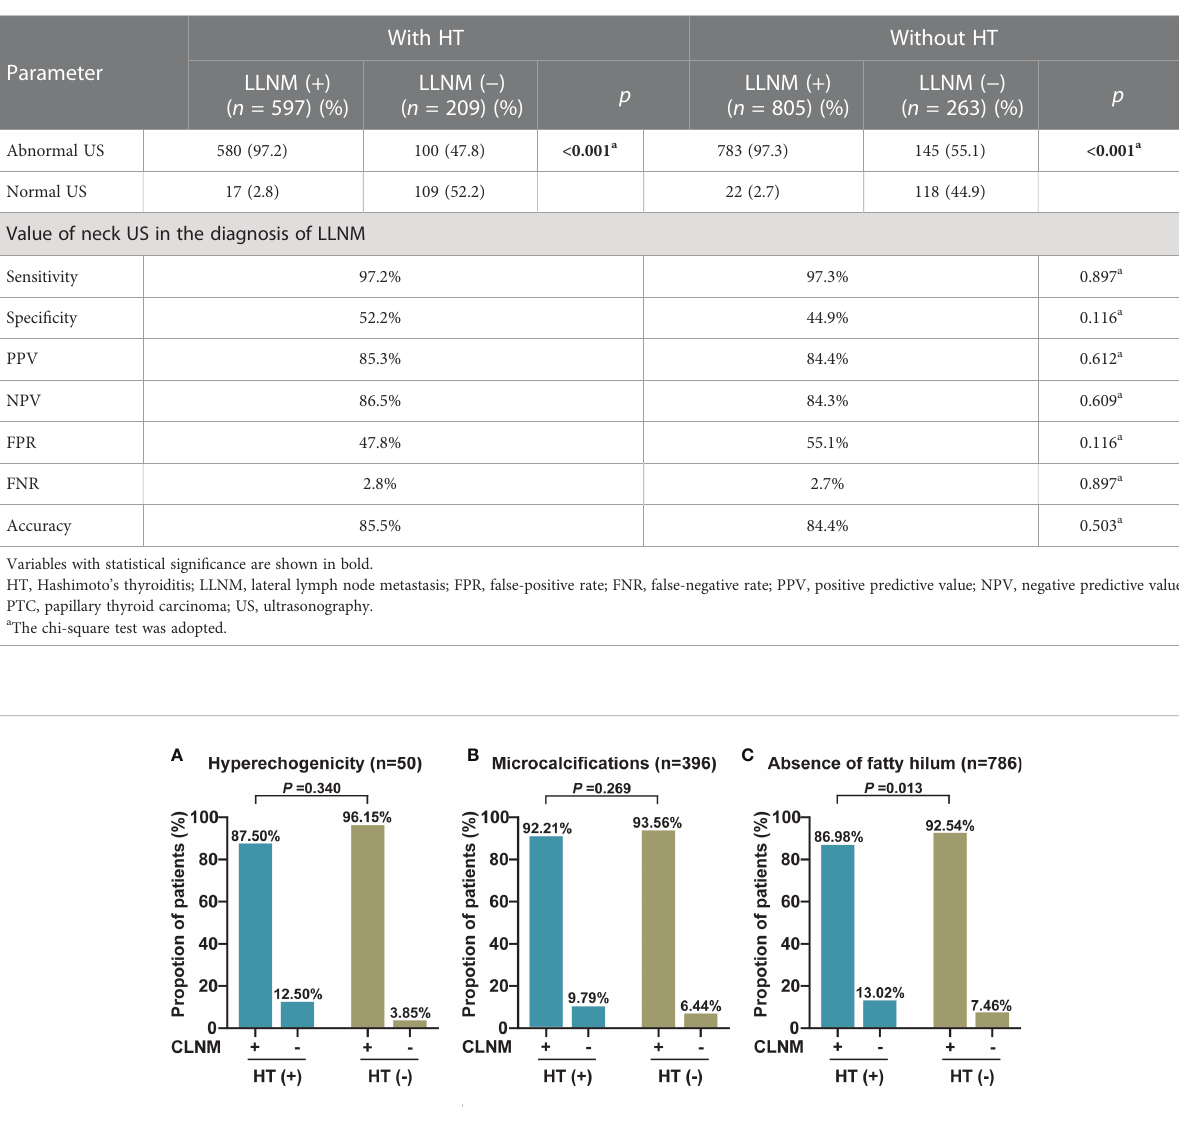
TABLE 3 The diagnostic value for lateral compartment lymph node metastases in PTC patients with or without HT on neck US.